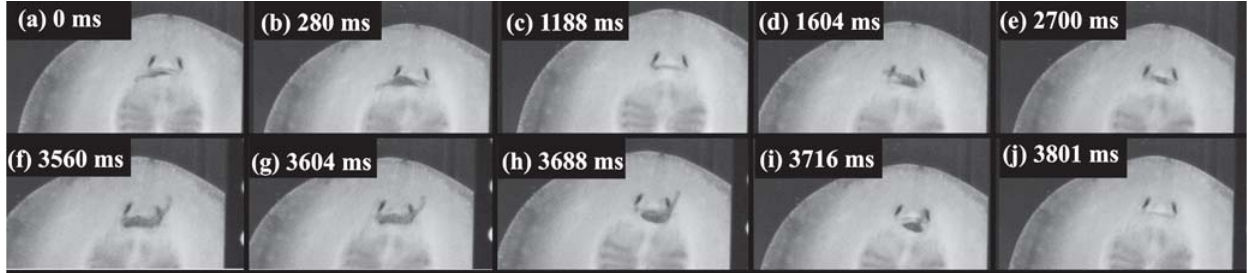
Fig. 4. Sequences of video frames showing prey manipulation by individual of Potamotrygon motoro in ventral view. Sequential time is indicated in each frame in milliseconds (ms).The sequence shows the prey capture ( a ) and its partial expel ( b - c ), followed by bite manipulation ( d - g ). The ingestion occurs after total suction of prey ( h - i ), then oral transport ( j ). Arrow indicates the prey position.